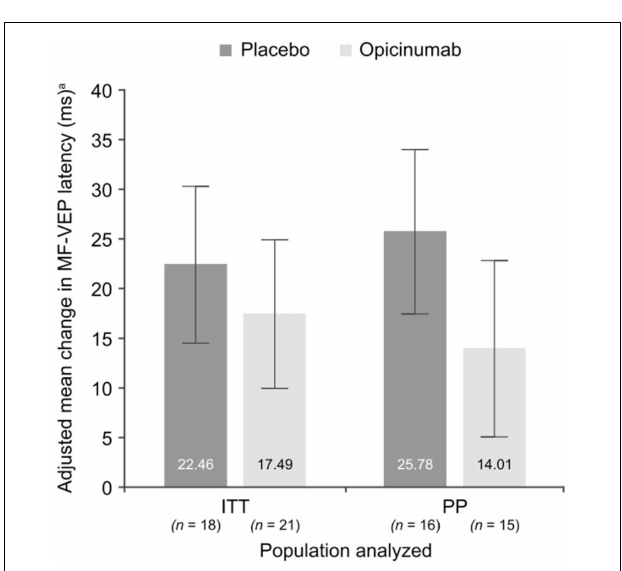
FIGURE 7 | Mean change in mfVEP latency, adjusted for the baseline latency of unaffected fellow eye, at week 24 in the affected eye compared with the unaffected fellow eye at baseline in the substudy ITT and PP populations [from Klistorner et al.